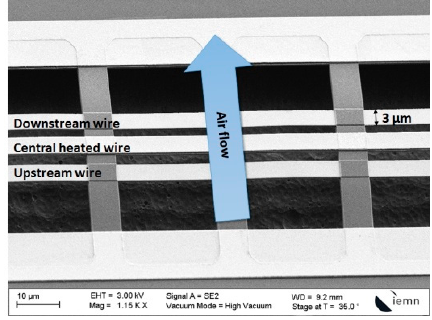
Figure 1. SEM picture and schematic of the sensor